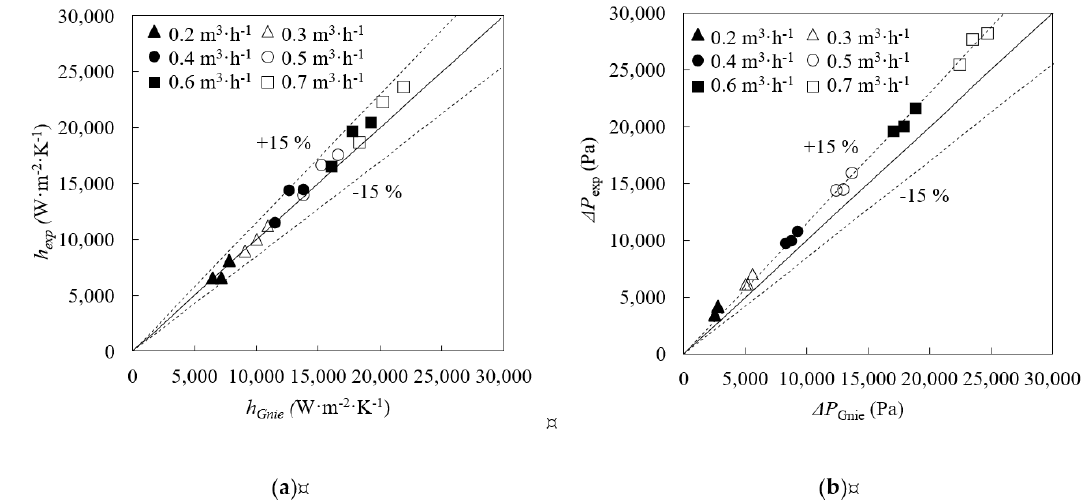
Figure 2. Comparison between experimental, exp and Gnielinski, Gnie, results for water. ( a ) Convection heat transfer coefficients, h . ( b ) Pressure drop, ∆ P